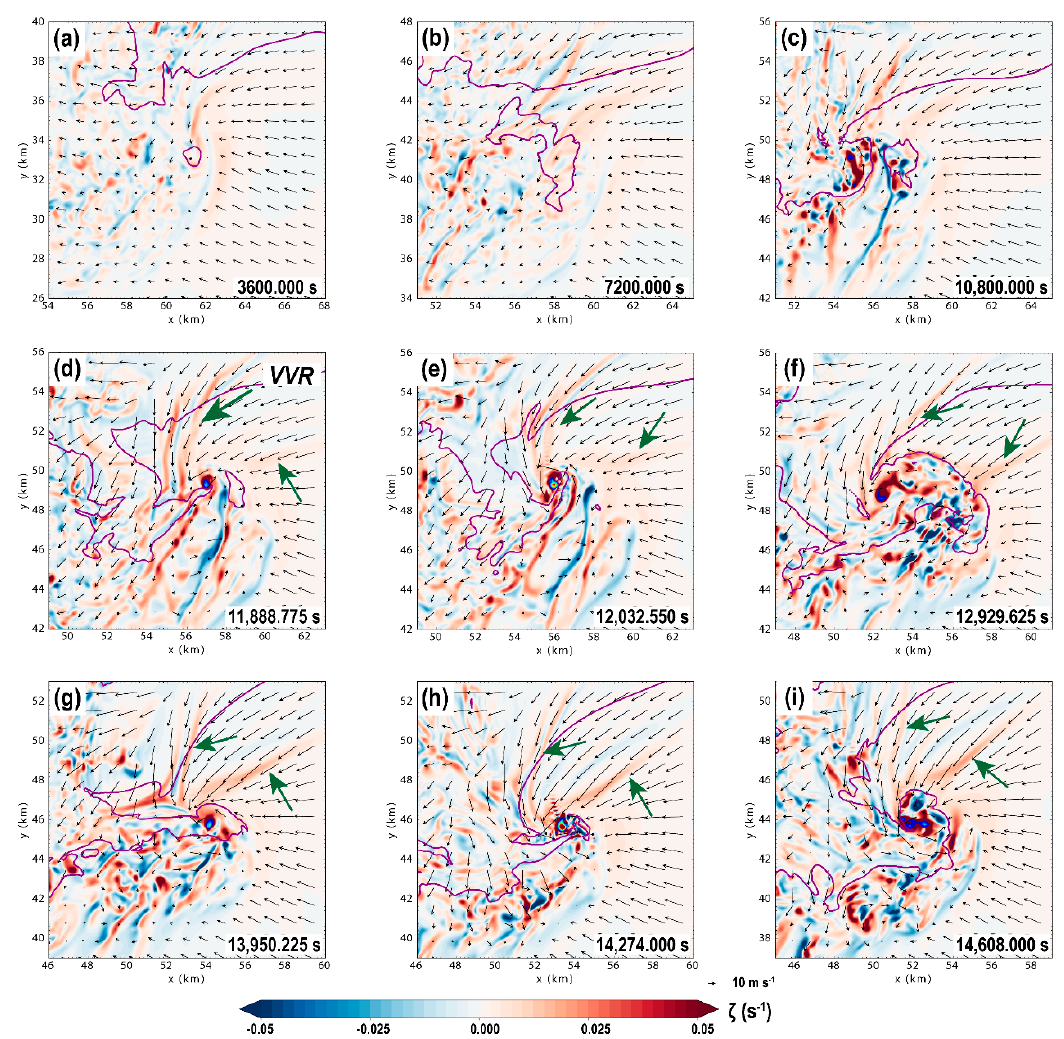
Figure 2. Select stages of the simulated supercell life cycle. ( a ) 3600.000 s, ( b ) 7200.000 s, ( c ) 10,800.000 s, ( d ) 11,888.775 s, ( e ) 12,032.550 s, ( f ) 12,929.625 s, ( g ) 13,950.225 s, ( h ) 14,274.000 s, and ( i ) 14,608.000 s. Vertical vorticity (light shading; s − 1 ), horizontal wind (vectors; m s − 1 ), and the 0.3 g kg − 1 rainwater mixing ratio contour. Vertical vorticity rivers (VVR, in (d)) are denoted by green arrows in ( d )–( i ). Pockets of strong vertical vorticity associated with the tornadoes in the center of the domain are shaded in the foreground, starting at 0.1 s − 1 . All fields at 158 m AGL.